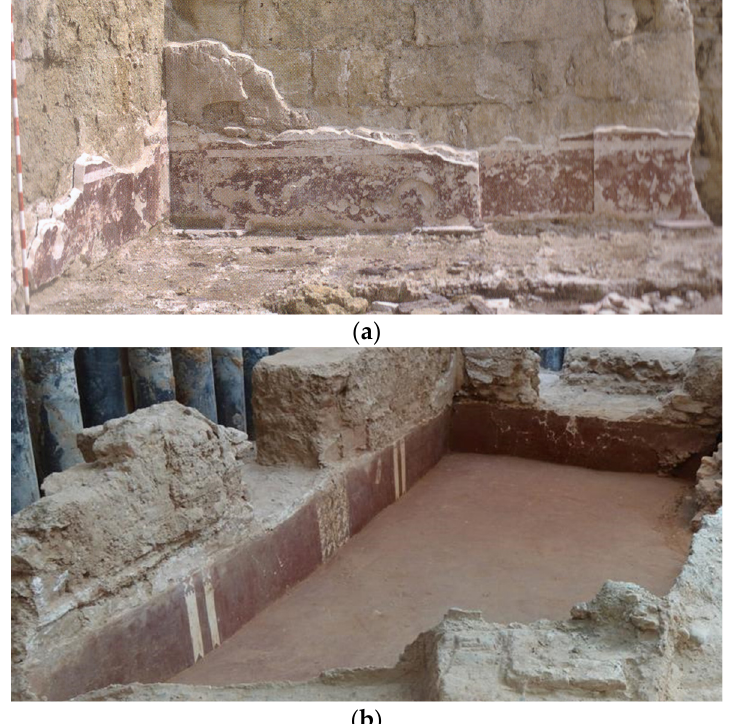
Figure 4. Red almagra plinths from the Ummayad/Taifa period: ( a ) Ya’far’s house, Mad ī nat al-Zahr ā ’ (Vallejo Triano 2010, p. 331; ( b ) Andalusi house in Plaza del Ángel, Valencia (Parrilla 2022).